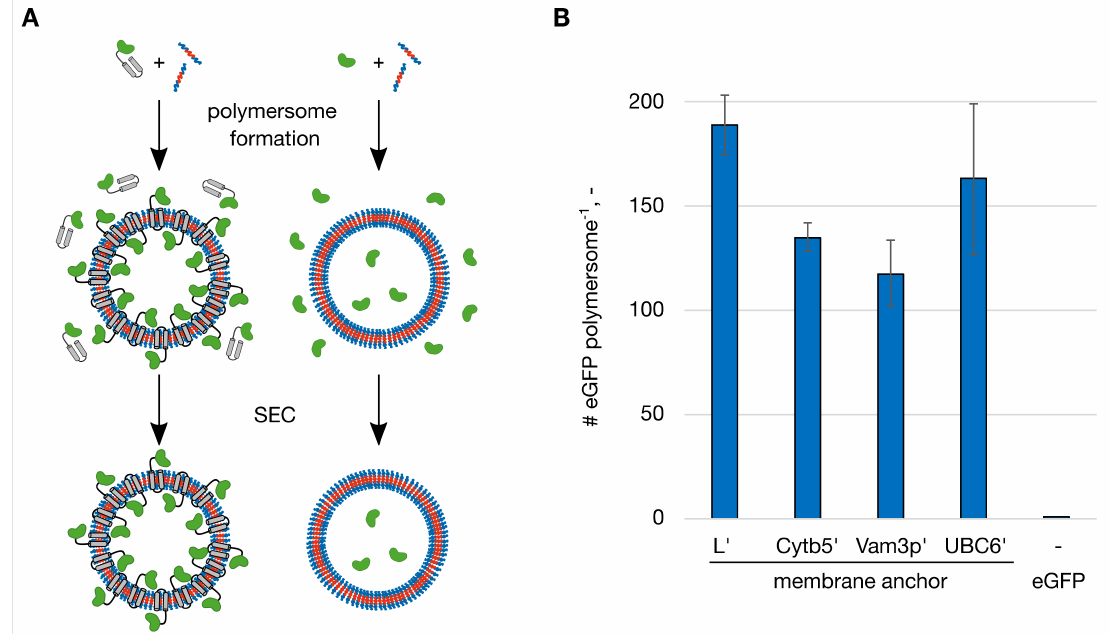
Figure 1. Functionalization of polymersomes with membrane-anchoring enhanced green fluorescent protein (eGFP). Polymersomes were functionalized with fusion proteins of eGFP and the membrane-anchoring peptides L’, Cytb5 (cid:48) , Vam3p’ and UBC6 (cid:48) and without a membrane-anchoring peptide (eGFP). ( A ) The proteins with (left) or without (right) membrane anchor were mixed with the amphiphilic polymer (blue: hydrophilic blocks, red: hydrophobic block). The eGFP domains are shown in green, the membrane anchoring domains in grey. After polymersome formation, the dispersions were processed by size-exclusion chromatography (SEC) to separate the functionalized vesicles from unincorporated protein. ( B ) Number (#) of eGFP molecules per polymersome after the functionalization. The proteins were applied at a concentration of 0.50 g/L with the exception of eGFP-UBC6 (cid:48) (0.40 g/L). Error bars represent the standard deviation in technical